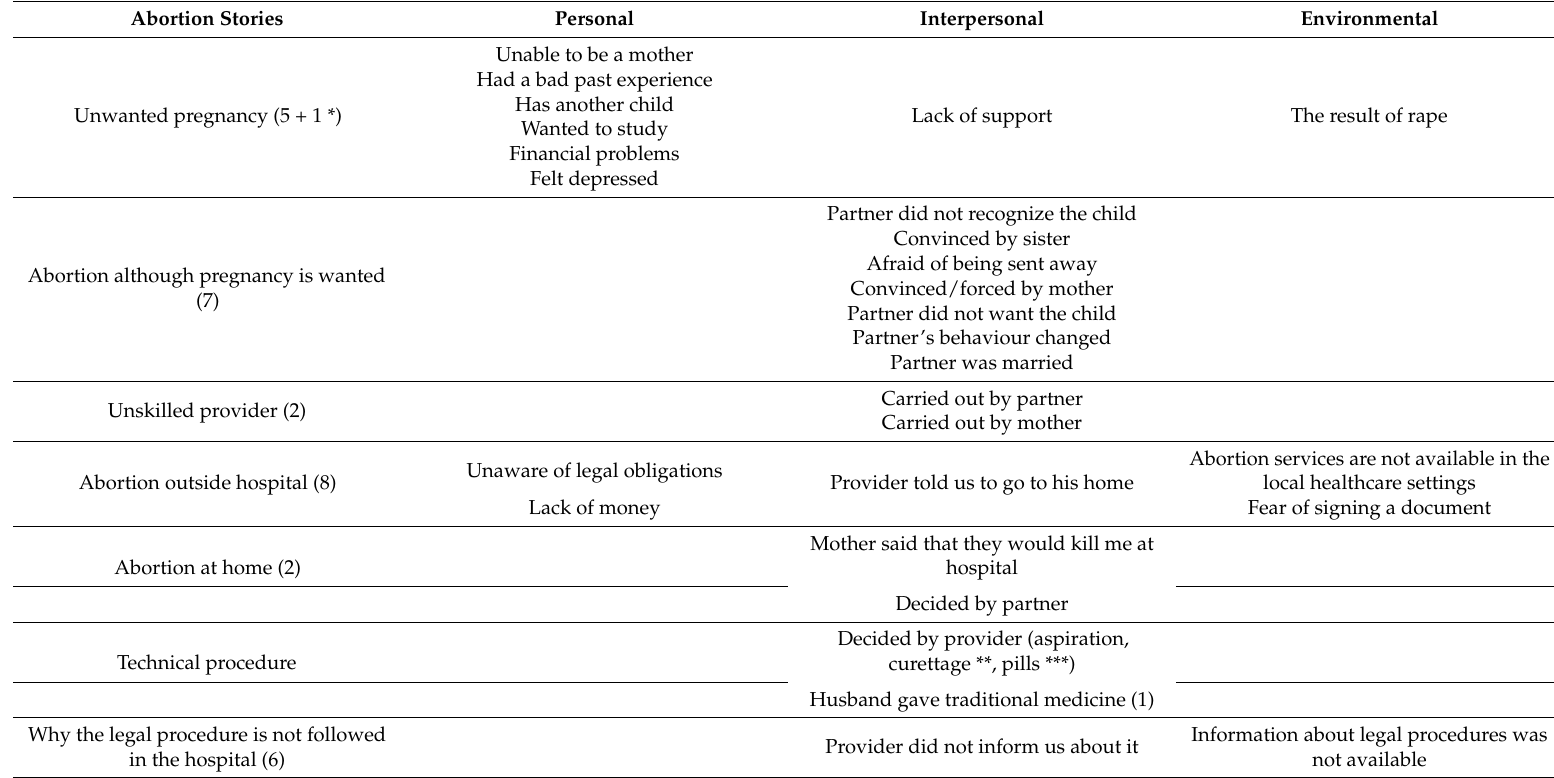
Table 2. Summary of induced abortion stories. (We changed the table format, please